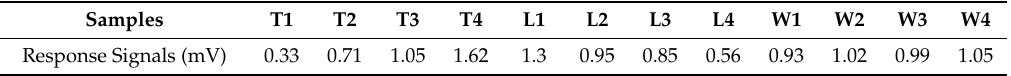
Table 2. Response signals of the IPMC